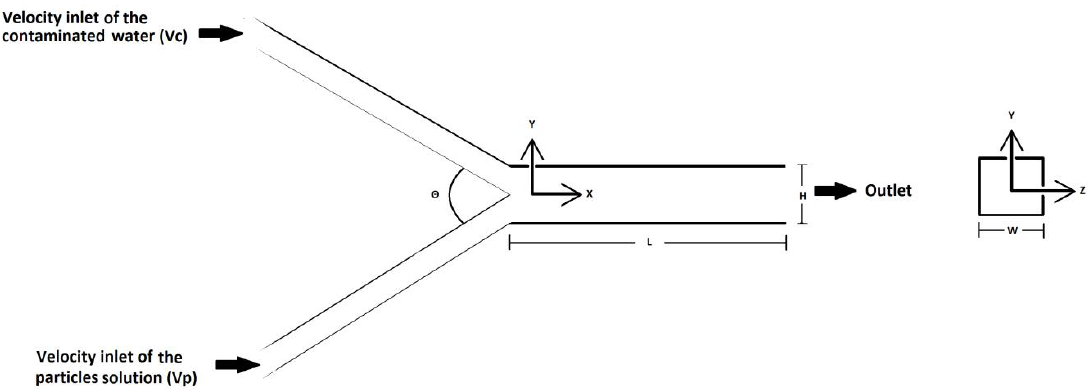
Table 1. Computational grid for the investigated geometries.